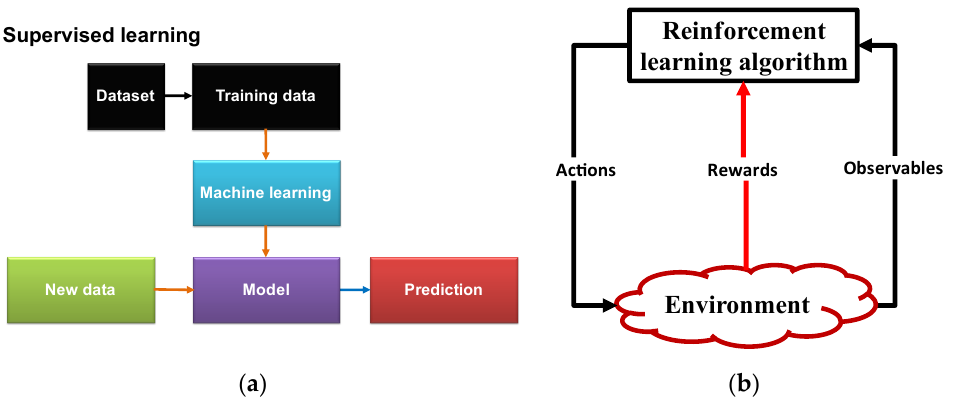
Figure 6. Schematics for two well-known machine learning techniques: ( a ) supervised learning (SL) and ( b ) reinforcement learning (RL) [13].